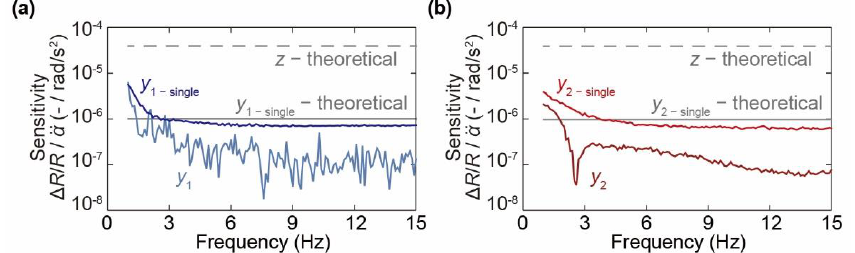
Figure 11. Canceling the y -axis sensitivity in each sensor unit. ( a ) Sensor unit 1 and ( b ) sensor unit 2.